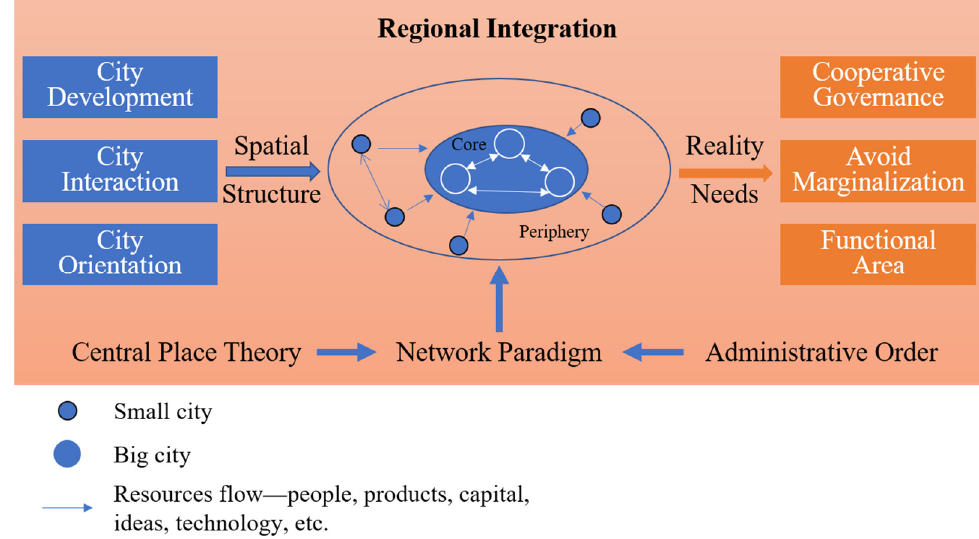
Figure 8. A simplified summarization map of this study.